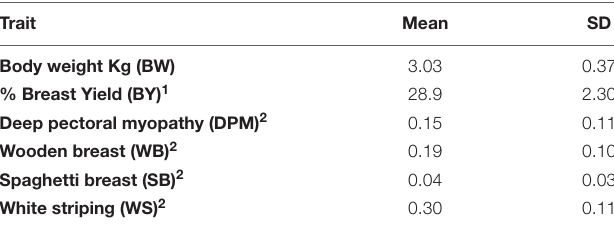
TABLE 4 | Descriptive statistics for the traits used in study 1 for the estimation of genetic parameters in the pure broiler line. Trait